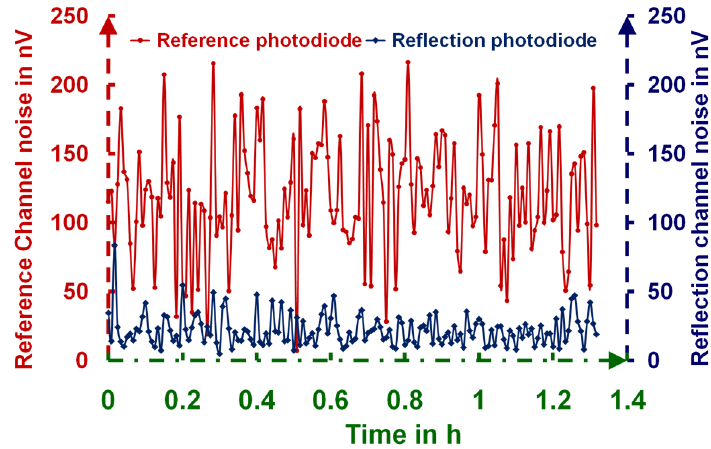
Figure 9. Photodiode noise with daylight and interference filter.